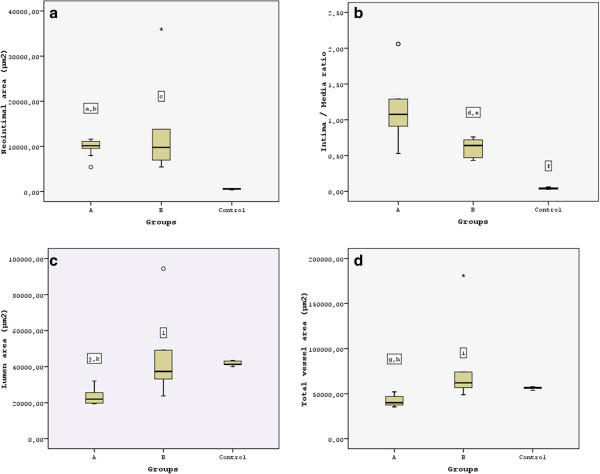
Comparison of neointimal area, intima/media ratio, lumen area and total vessel area between groups. a. Atherogenic diet and balloon angioplasty induced significant intimal hyperplasia in hyperlipidaemic rabbits: a P = non significant, Tamhane’s post hoc ANOVA analysis vs Group B; b P < 0.001, Tamhane’s post hoc ANOVA analysis vs control; c P < 0.05, Tamhane’s post hoc ANOVA analysis vs control. b. A significant increase in intima/media ratio was observed in angioplasty induced atherosclerotic lesions: d P < 0.05, Tamhane’s post hoc ANOVA analysis vs Group A; e P < 0.001, Tamhane’s post hoc ANOVA analysis vs Control; f P < 0.001, Tamhane’s post hoc ANOVA analysis vs Group A. c. Angioplasty resulted in a significant reduction in lumen of injured thoracic aortas: j P = 0.05, Tamhane’s post hoc ANOVA analysis vs Group B; k P < 0.001, Tamhane’s post hoc ANOVA analysis vs control; l P = non significant, Tamhane’s post hoc ANOVA analysis vs control. d. Injured thoracic aortas demonstrated a significant decrease in total vessel area consistent with constrictive remodeling occurrence: g P < 0.05, Bonferroni’s post hoc ANOVA analysis vs Group B; h P = non significant, Bonferroni’s post hoc ANOVA analysis vs control; i P = non significant, Bonferroni’s post hoc ANOVA analysis vs control.